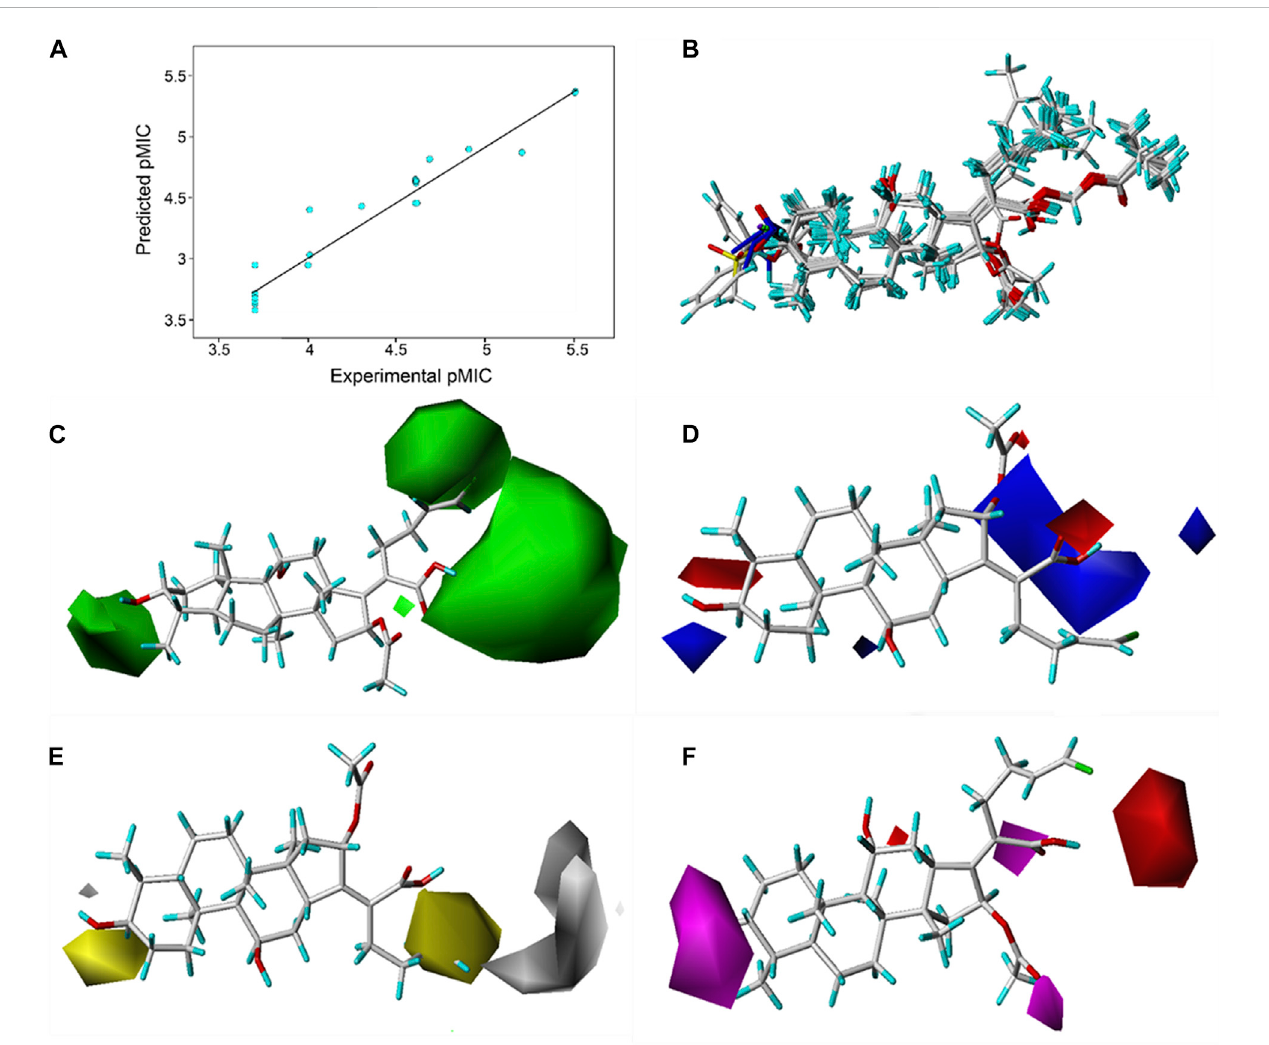
FIGURE 3 (A) Relationship between the experimental and predicted antibacterial activities by the QSAR model, pMIC = -lg MIC, showing R 2 = 0.921; (B) fl exible alignment ofderivatives showninthestickmodel; (C) steric fi elds,greenfavorableandyellowdisfavored; (D) Phaseelectrostatic fi elds, bluefavorableand red disfavored; (E) hydrophobic fi elds, yellow favorable and white disfavored; and (F) H-bond acceptor fi elds, magenta favorable and red